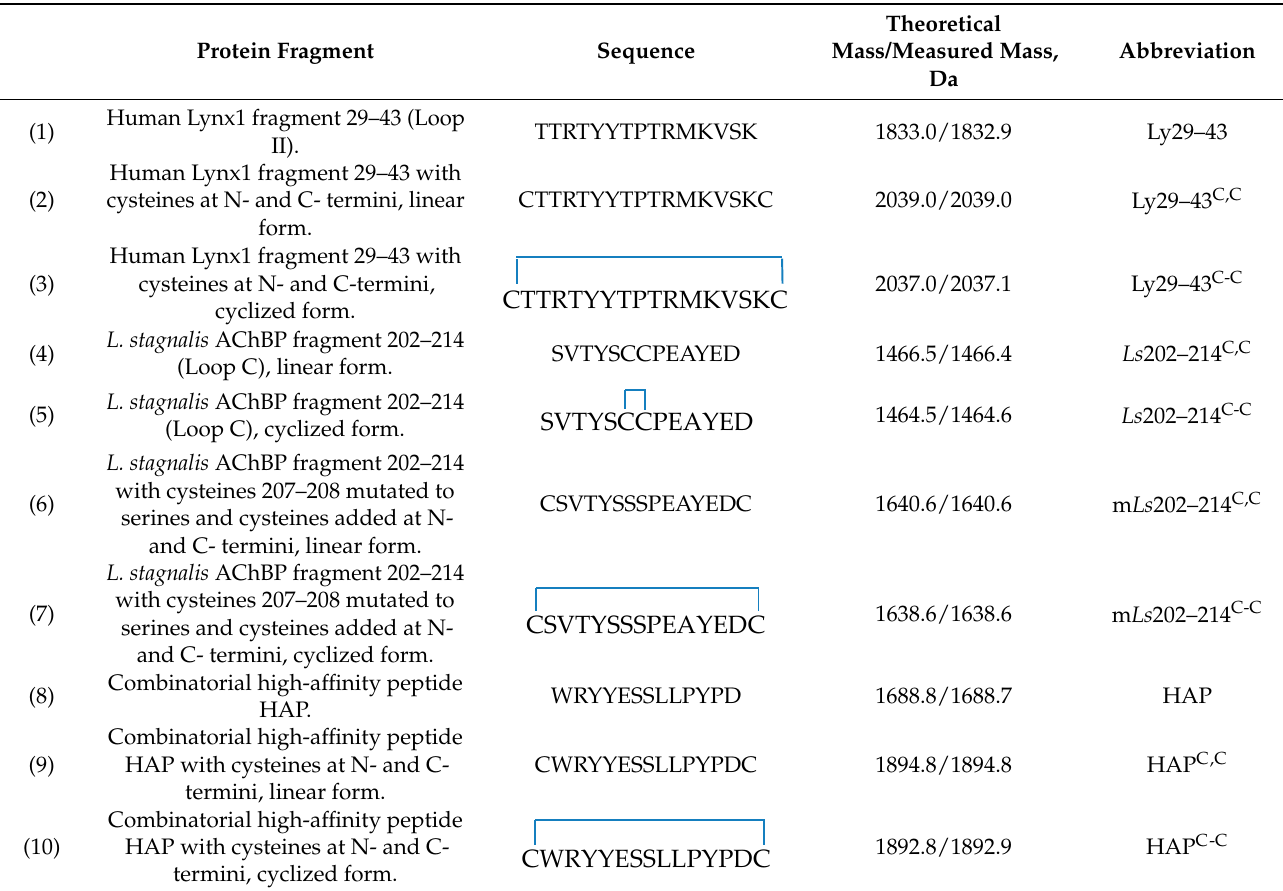
Table 1. Synthetic fragments of Lynx1 central loop, L. stagnalis AChBP loop C and HAP with their abbreviations and measured molecular masses.